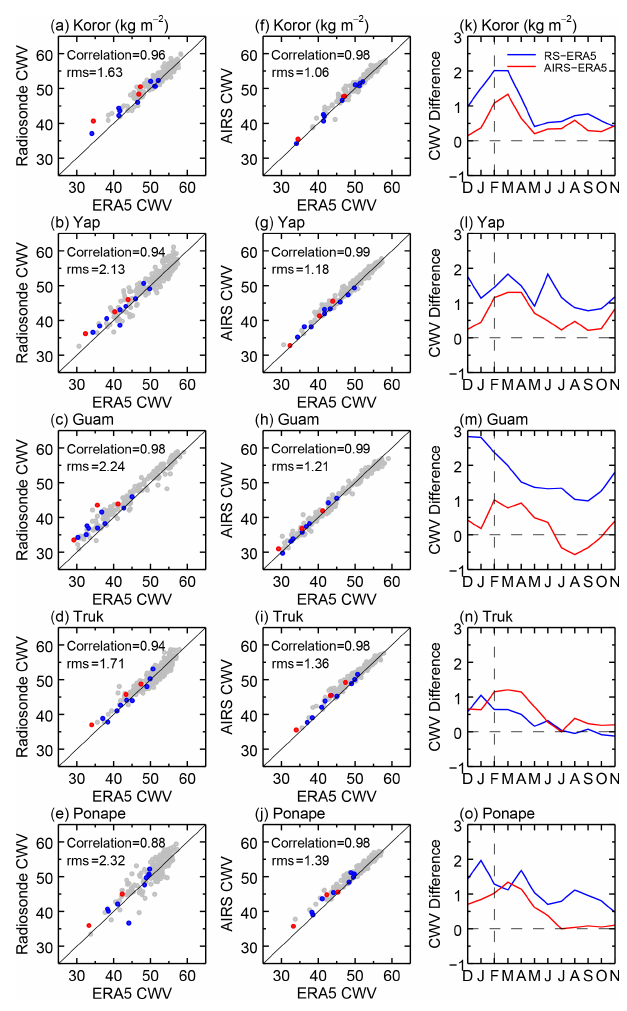
Figure 13. Scatterplots of monthly mean CWV in winter derived from (a–e) radiosonde and (f–j) AIRS observations against corre- sponding CWV from ERA5 reanalysis and (k–o) climatic mean CWV difference (blue lines) between radiosonde and ERA5 reanal- ysis data and (red lines) between AIRS and ERA5 reanalysis data at five stations during 2005–2019. In (a–j) , the red, blue, and gray dots denote the CWV values in the 2009/10 winter; the 2006/2007, 2015/2016, and 2018/2019 winters; and the other winters, respec-